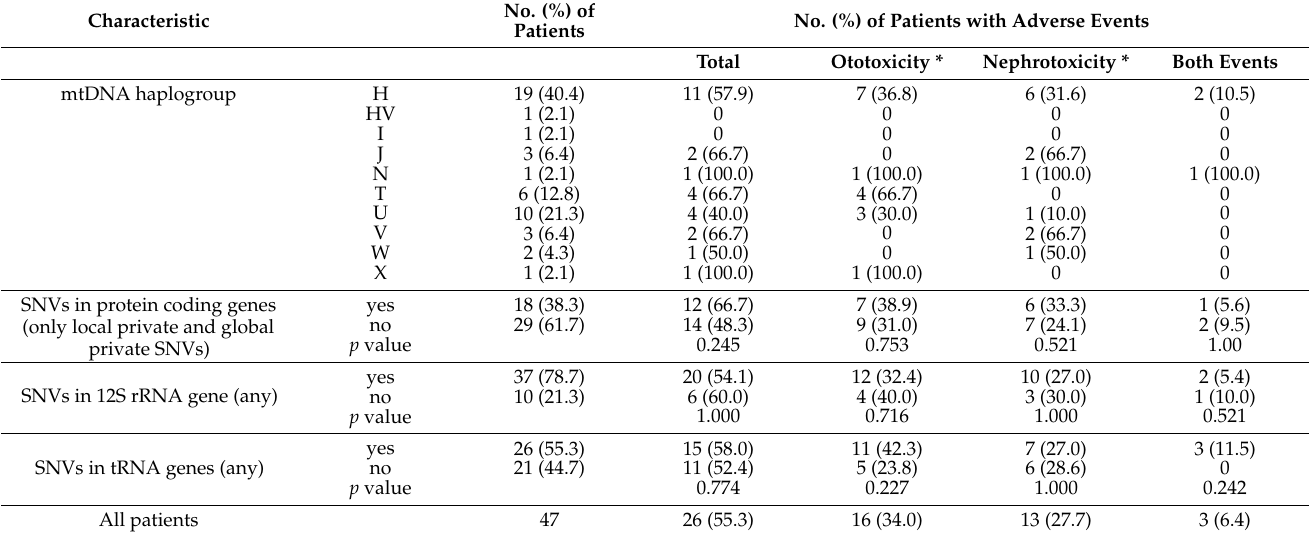
Table 2. The occurrence of ototoxicity and nephrotoxicity in patients with MDR-TB depending on mtDNA genetic